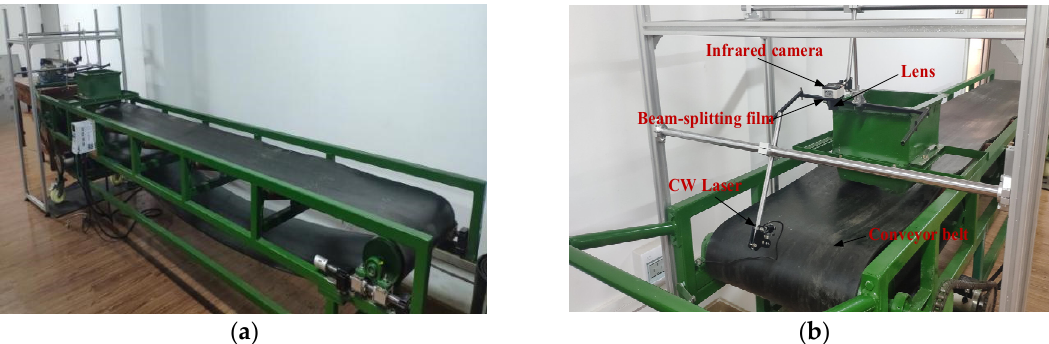
Figure 8. ( a ) Laboratory test of belt conveyor; ( b ) The experimental platform of mini-crack detection system based on laser thermography.